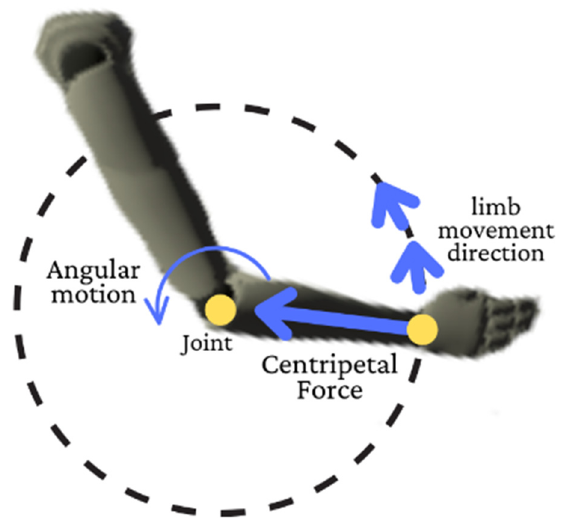
Figure 1. Angular motion of a human joint.